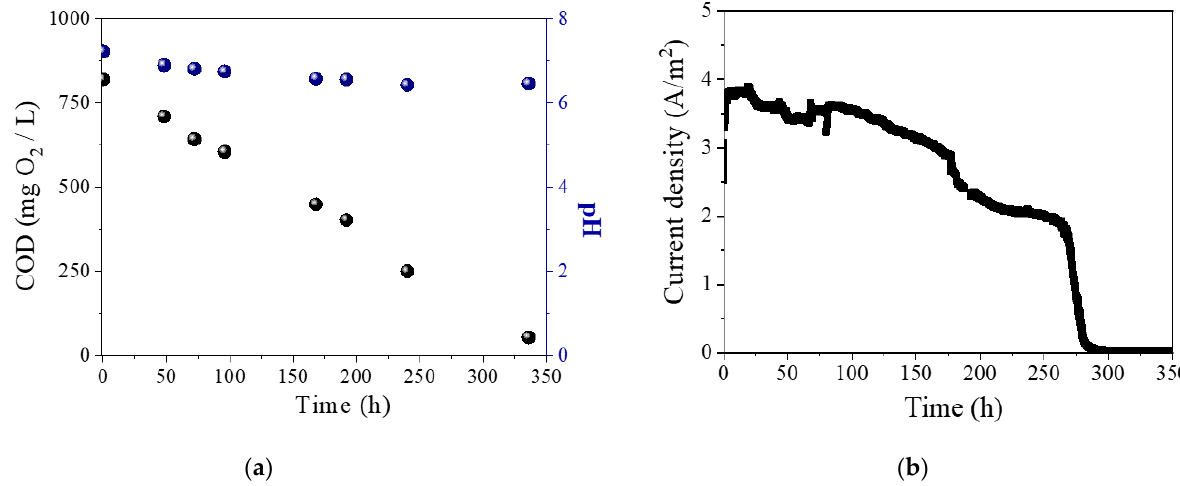
Figure 4. ( a ) COD, pH of the anolyte, and ( b ) current density (normalized to the anodic surface area, 2 × 2 cm 2 ) for MEC1 vs. operation time, for an acetate-based synthetic wastewater feed. Applied cell potential: 0.9 V.